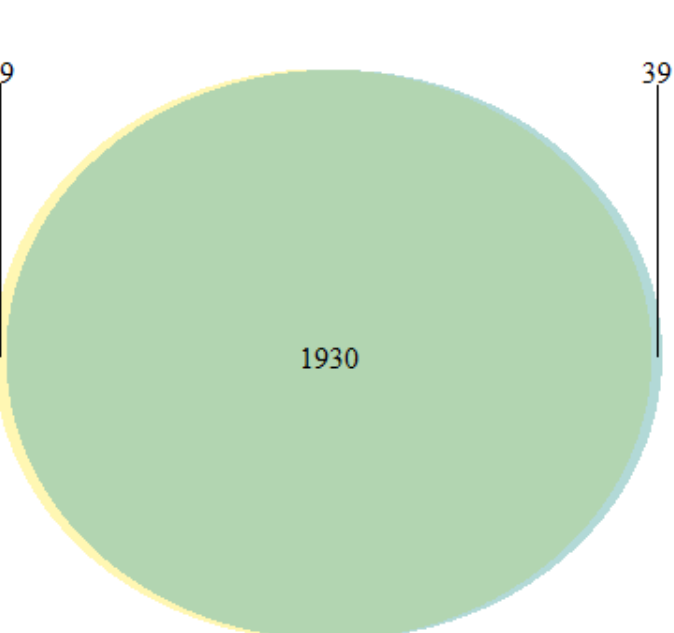
Figure 11. Venn diagram for the proteome of underyearlings of Atlantic salmon ( Salmo salar L.) for the control and experimental groups.